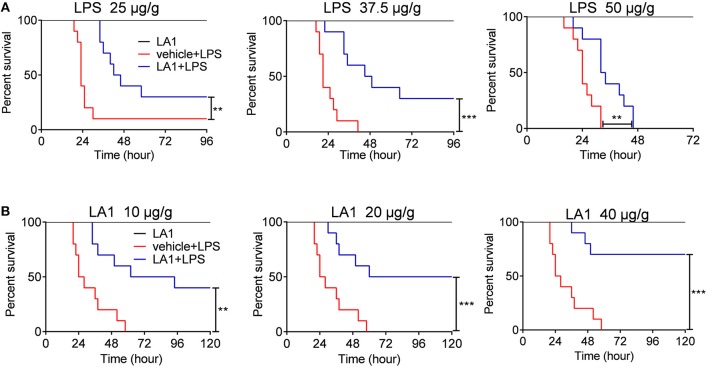
Activation of CD11b by LA1 reduced LPS-induced mortality. (A) C57BL/6 mice were treated with either LA1 (40 μg/g of body weight) or vehicle followed by LPS stimulation (25, 37.5, and 50 μg/g of body weight). The survivals of mice were observed (n = 10 mice/group) **P < 0.01, ***P < 0.001. Kaplan–Meier method was used to estimate overall survivals and the survival rates were determined by Log-rank test. (B) C57BL/6 mice were treated with either LA1 (10, 20, and 40 μg/g of body weight) or vehicle followed by LPS (37.5 μg/g of body weight) stimulation. The survivals of mice were observed (n = 10 mice/group) **P < 0.01, ***P < 0.001. Kaplan–Meier method was used to estimate overall survivals and the survival rates were determined by Log-rank test.